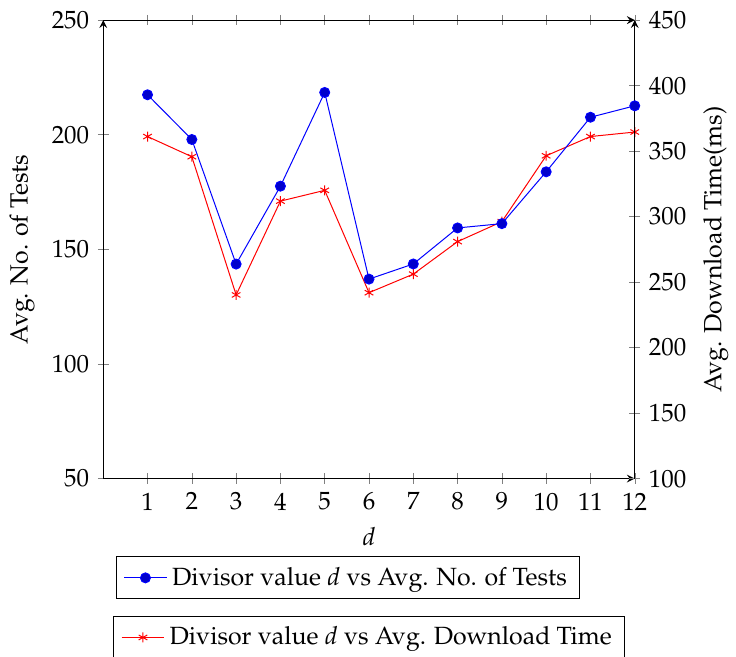
Figure 11. Comparison for number of tests counts and download time. d is the divisor to # N j in the plaintext name to get the number of input to the PEKS